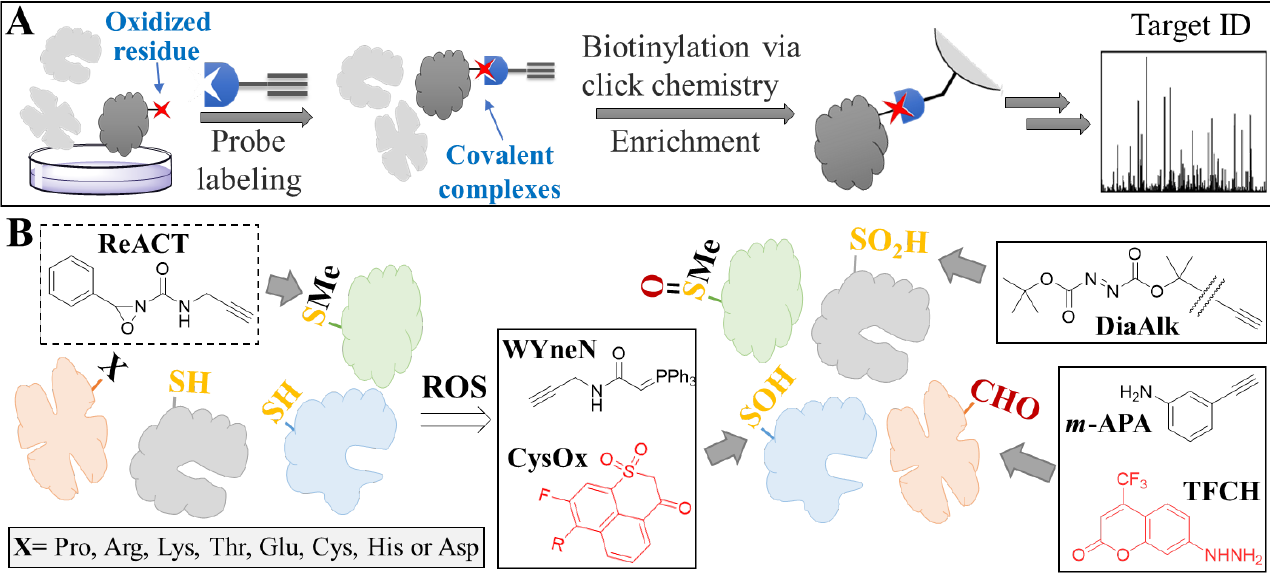
Figure 6. Chemical proteomics-based identification of oxidized proteins. ( A ) General workflow of chemical proteomics. The proteome of interest consisting of non-oxidized (indicated as light gray) and oxidized (indicated as dark gray. Oxidized residue is depicted as a red star) proteins is treated with a probe specific for an oxidized amino acid. Upon reaction with the target protein, a covalent complex is formed. Following cell lysis, the probe-modified proteins are biotinylated (using click chemistry) and enriched with streptavidin beads. Finally, digestion and analysis by LC-MS/MS leads to target identification. ( B ) Tagging of proteins with small molecule probes. Upon oxidation with ROS, amino acid residues are modified. The structures of the probes targeting different amino acids, suitable either for imaging (red structures) or chemical proteomics, are shown in boxes. Gray arrows show which probes react with which amino